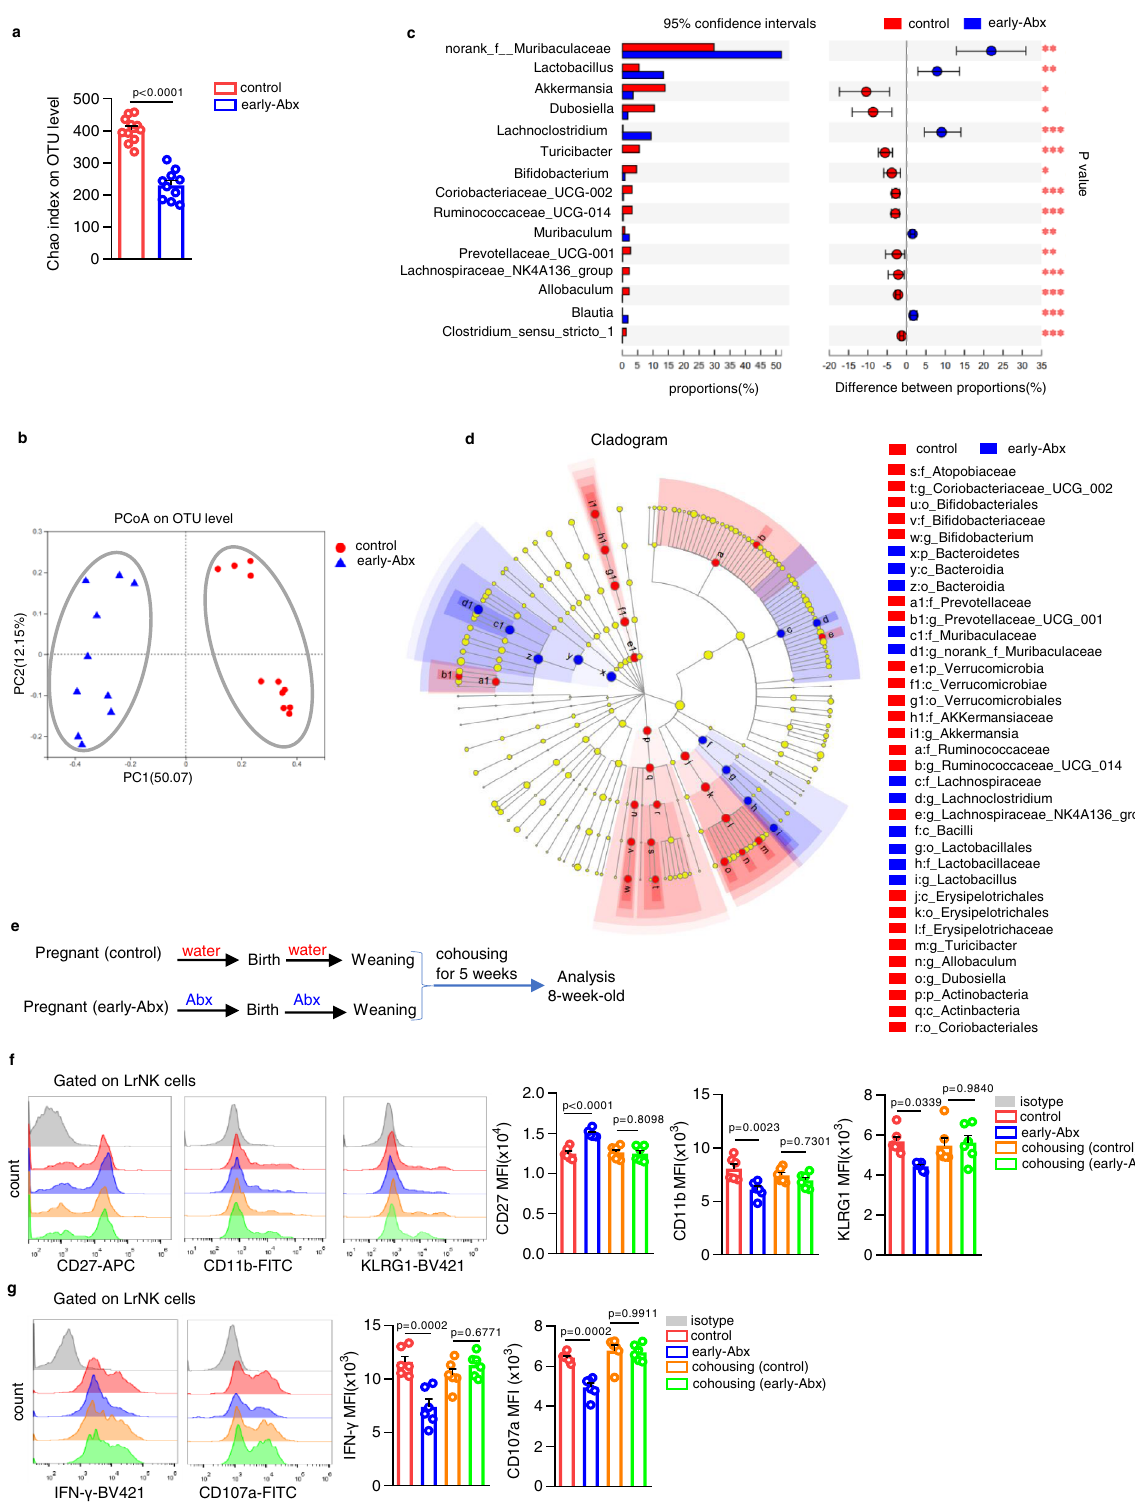
Fig. 3 | The persistent microbiota dysbiosis is responsible for maturation arrest of LrNK cells in early-Abx-treated mice. a – d 16S rRNA sequencing was performed with feces from control and early-Abx mice (control n =11, early-Abx n =10). Alpha diversity comparison via chao index analysis and beta diversity comparison via PCoA analysis. c Genus level comparison of gut commensal micro fl ora between control (red) and early-Abx (blue) mice. d LEfSe (linear dis- criminant analysis size effect) predictions for bacterial families in fecal pellets of control (red) and early-Abx (blue) mice were shown. e Experimental scheme of cohousing mouse model. f Representative FACS plots and bar graph for the